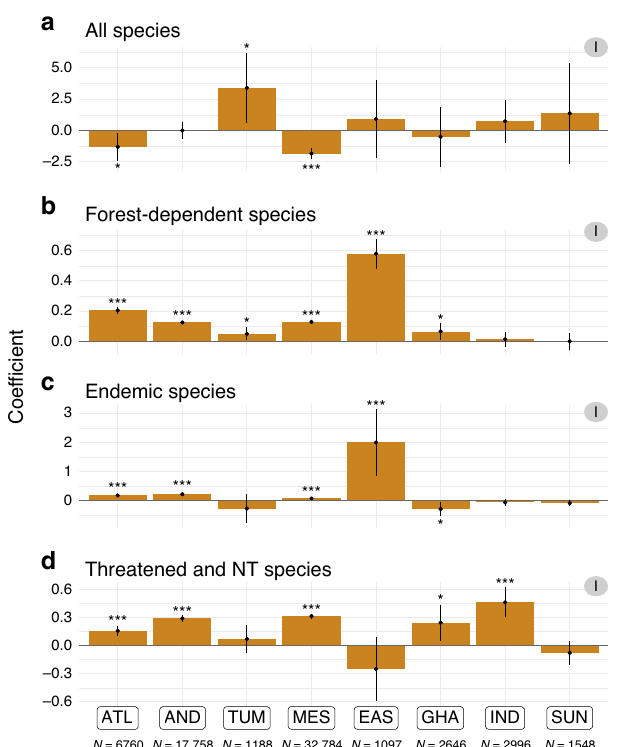
Fig. 3 Effect of protected areas on bird diversity per hotspot, for four bird diversity indices (analysis I). a Overall species richness. b Forest- dependent species richness. c Endemic species richness. d Richness in threatened and Near Tthreatened species. Coef fi cients correspond to the estimates of GAM models; signi fi cance is given by the P value (***<0.001 < **<0.01 < *<0.05, see details in Supplementary Table 3) and the 95% con fi dence interval around GAM coef fi cients (vertical error bars). Hotspots: ATL (Atlantic Forest), AND (Tropical Andes), TUM (Tumbes- Chocó-Magdalena), MES (Mesoamerica), EAS (Eastern Afromontane), GHA (Western Ghats and Sri Lanka), IND (Indo-Burma), and SUN (Sundaland). Number of checklists per hotspot is speci fi ed below hotspots names; more detailed results in Supplementary Table 1.